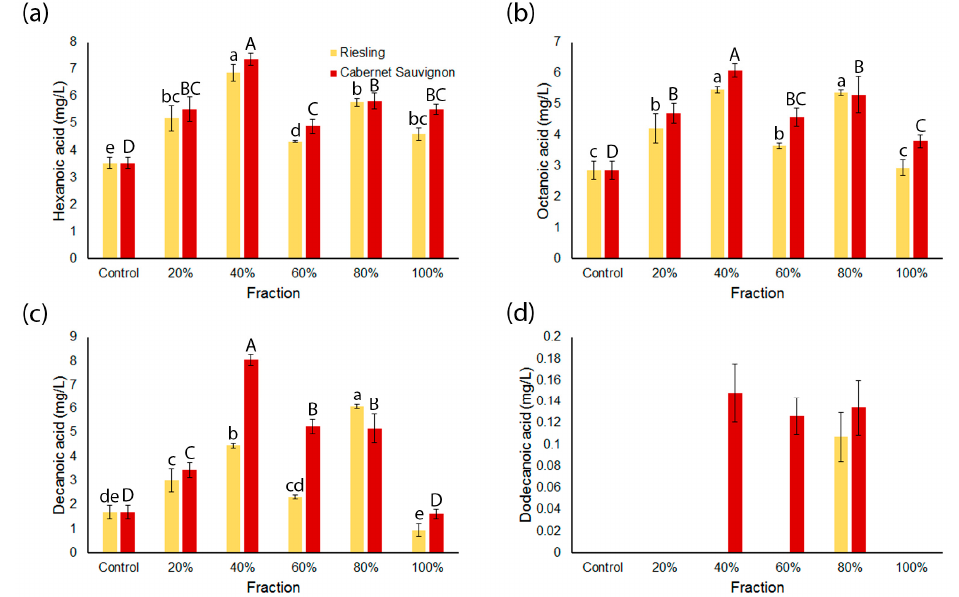
Figure 3. Concentrations of medium chain fatty acids (MCFA) in wines fermented after addition of grape fractions. ( a ) Hexanoic acid; ( b ) octanoic acid; ( c ) decanoic acid and ( d ) dodecanoic acid. Values represent the mean concentration of analyte relative to the internal standard ( n = 3); error bars represent the standard error; and different letters denote significant differences between treatments at p < 0.05 using ANOVA followed by Duncan’s new multiple range test. Lower case = Riesling series. Upper case = Cabernet Sauvignon series.